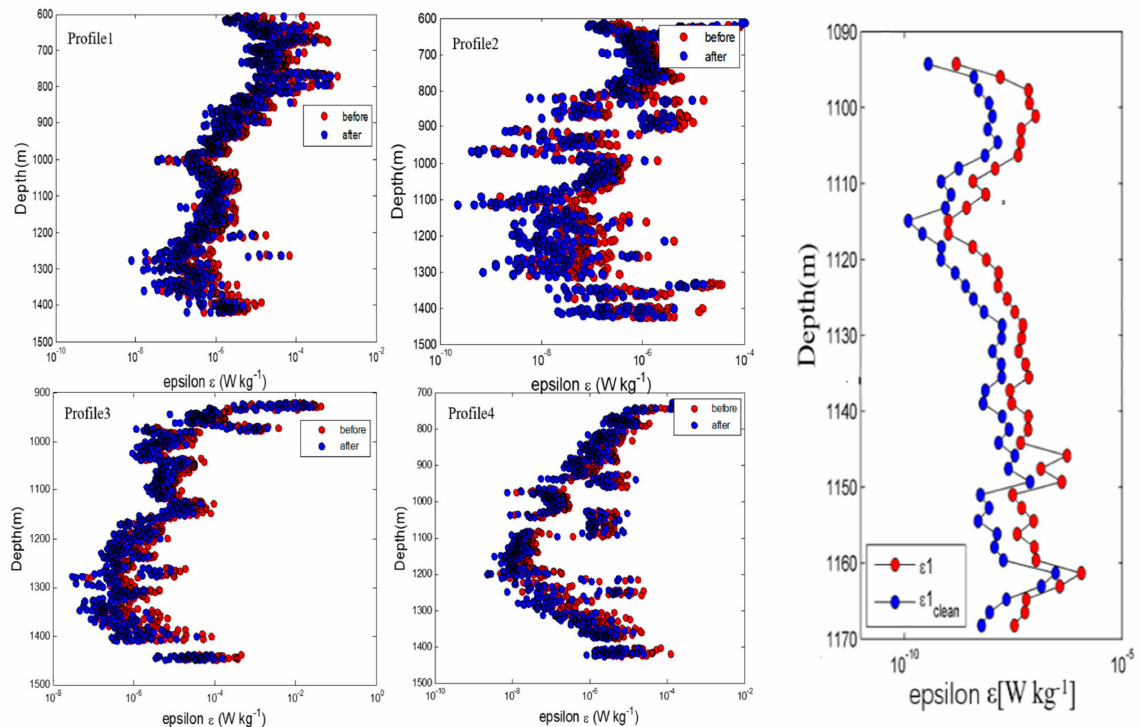
Figure 8. The raw dissipation rates (red dotes) and the cleaned dissipation rates (blue dotes) for four profiles using the classical cross-spectrum method for four profiles between 600 and 1500 m in deep sea. The right panel is the magnification of the dissipation rates between 1090 and 1170